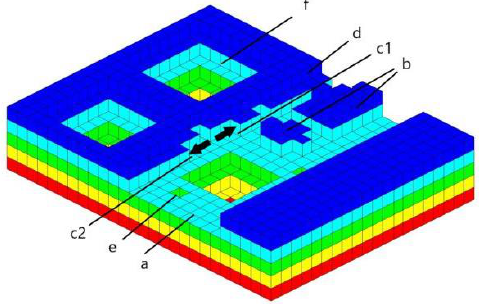
Figure 11. Schematic representation of crystal surface morphology: a, surface; b, island; c1, c2, positive and negative torsional folds; d, steps; f, dissolution pits/cavities; e, dislocation of points.